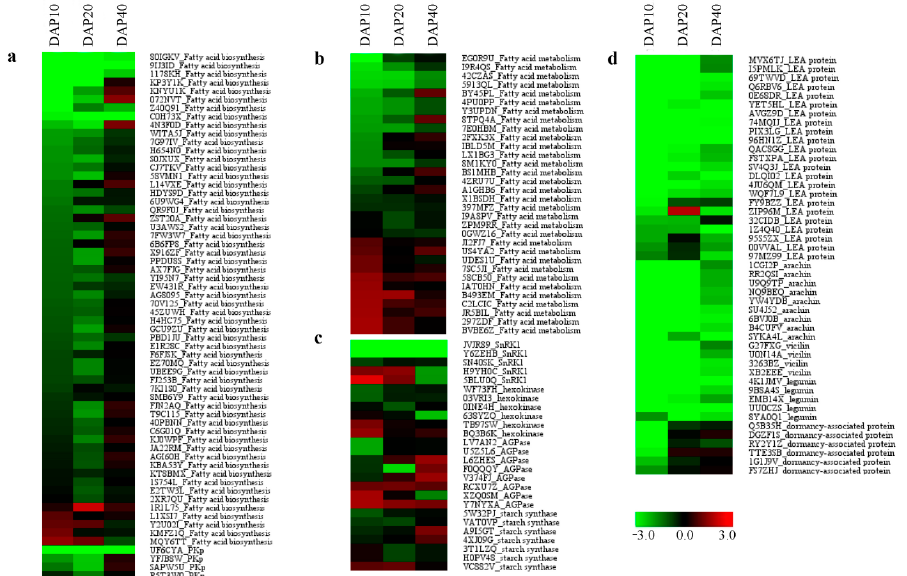
Figure 7. The expression pattern of storage reserves-related genes in seeds between ssm1 and LH11. Different expressions of the related genes of fatty acid biosynthesis ( a ), fatty acid metabolism ( b ), starch synthesis ( c ), and late embryogenesis abundant proteins ( d ) in seeds between ssm1 and LH11. Scale bar is located at upside with log 2 ratio value varying from green to red.